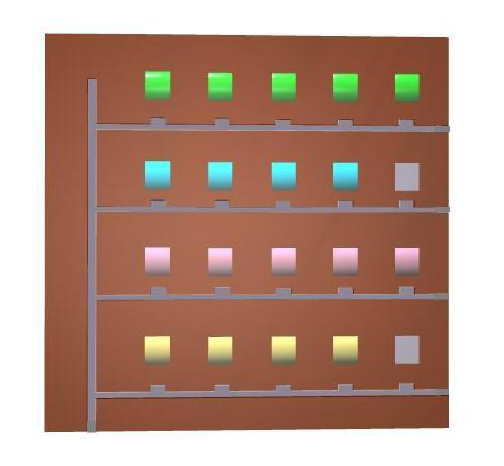
Figure 4: Shows a part of the v oter’s actual view. A glass pane covers the mechanical part, so the voter will not be able to touch the paper records. The voter can move the end of the marker over the track, but cannot touch the tip of the marker since it goes under the glass pane. The glass pane can be created in a way to magnify the spools. The marker (not shown) will be repositioned at the top left corner where it is refilled between the sessions. The marker will not be able to reach the empty compartments since the track will be physically blocked after the last occupied compartment.